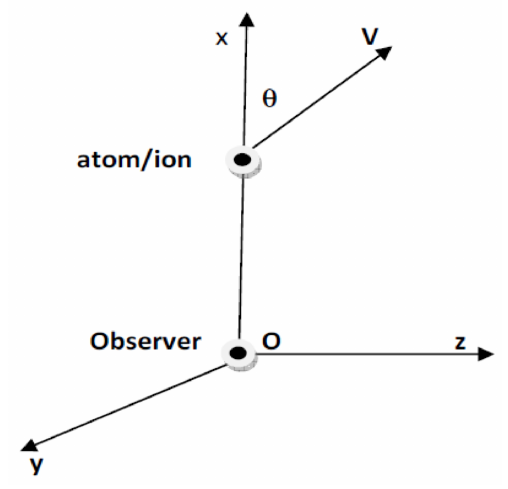
Figure 1. The fixed frame where the emitter moves with a velocity V forming an angle θ with the observation direction